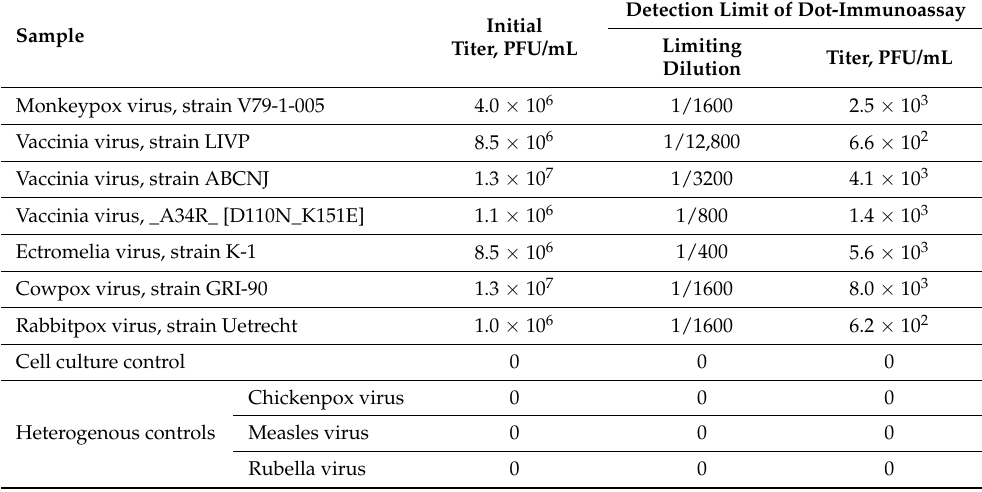
Table 2. Sensitivity of orthopoxviruses detecting by